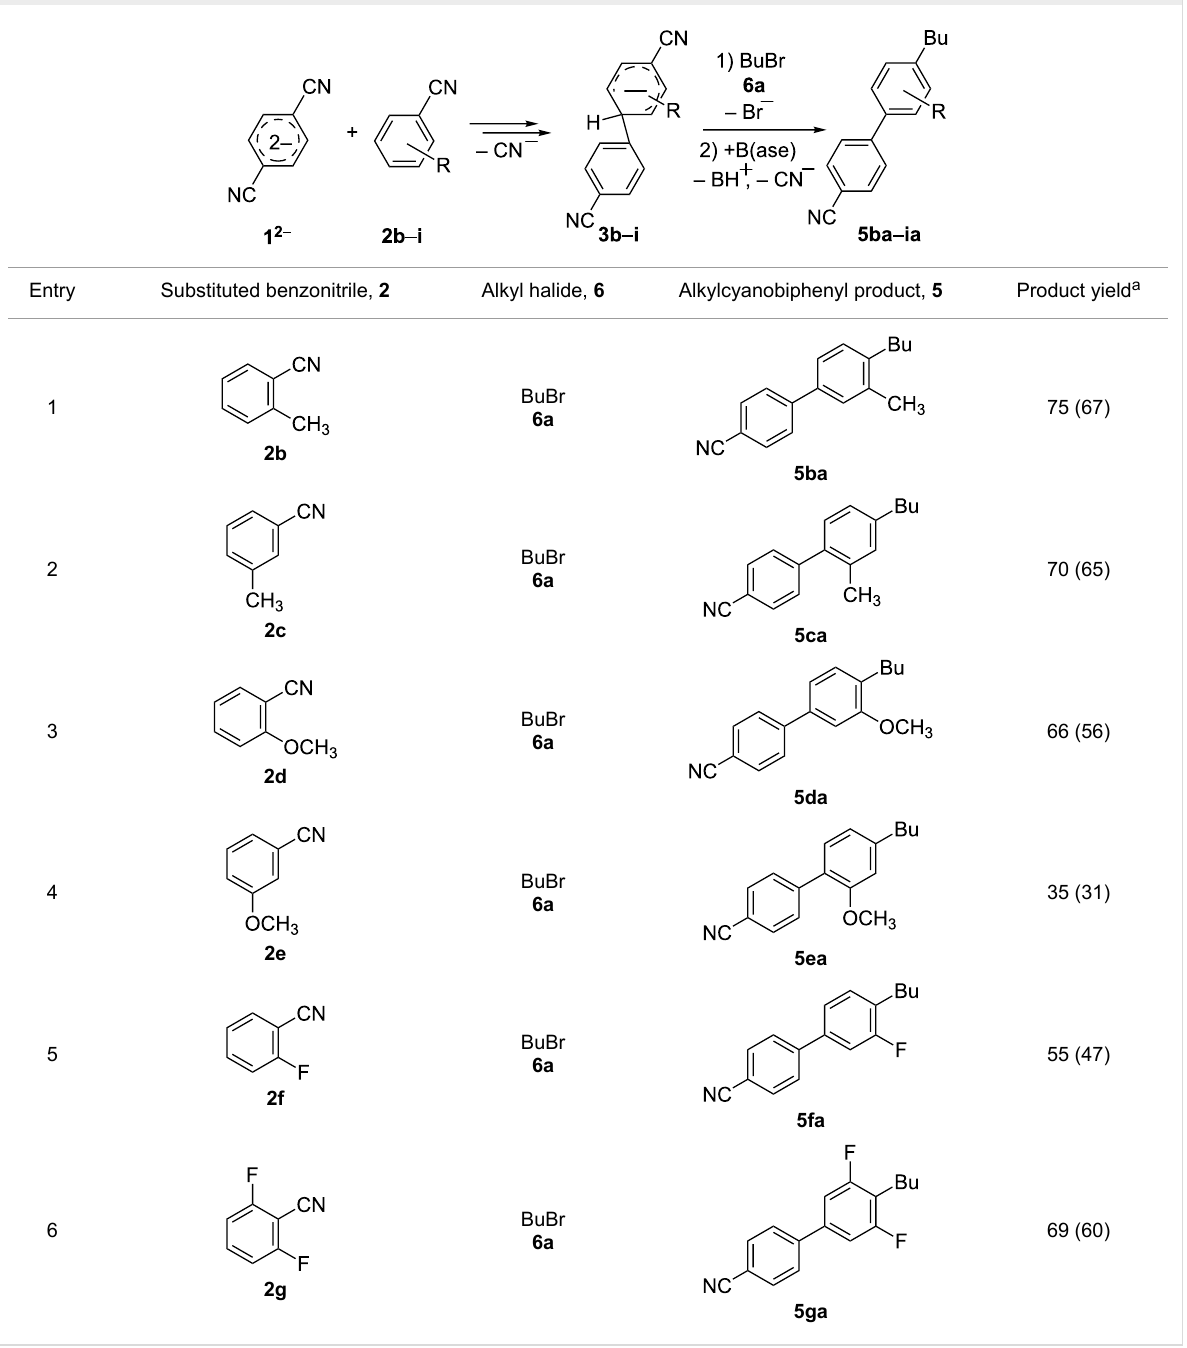
Table 2: Interaction of dianion 1 2 – with cyanoarenes 2b – i , followed by alkylation of intermediate anions 3b–i with butyl bromide 6a